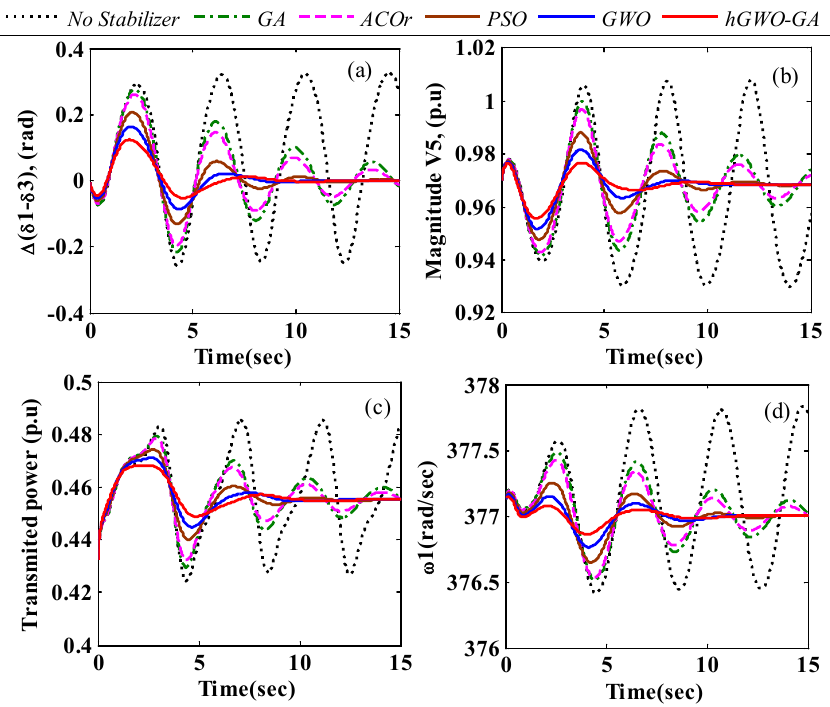
Figure 16. Nonlinear simulations in heavy loading using a robust φ -based stabilizer for different optimization algorithms (( a ) angle difference between G 1 and G 3 , ( b ) magnitude of voltage bus 5, and ( c ) transmitted power between area1 and area2, ( d ) rotor speed of generator G1).